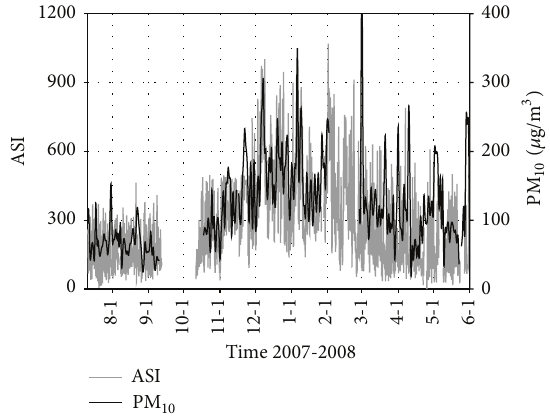
Figure 6: PM 10 and ASI measurement from July 11, 2007, to May 31, 2008 (data missing for instrument